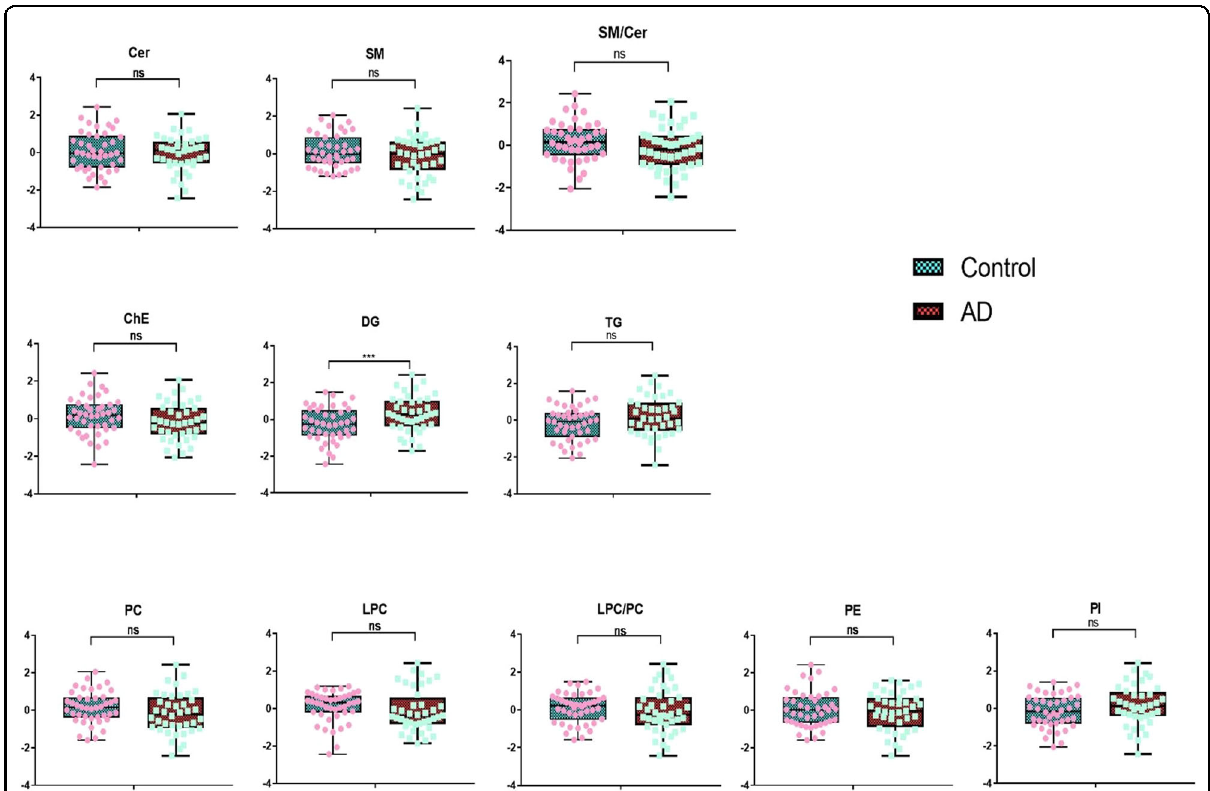
Fig. 3 Residuals of group lipids in AD and control group. Cer ceramides, SM sphingomyelins, ChE cholesteryl esters, DG diglycerides, TG triglycerides, PC phosphatidylcholines, LPC lyso-phosphatidylcholines, PE phosphatidylethanolamines, PI phosphatidylinositols. Dots in the plot represent the residuals of group lipids in each participant. Residuals were obtained after regression out age, sex, BMI, diabetes status, hypertension status, medication status for hypertension, and hyperlipidemia, APOE e4 carrier status, education, and current smoking status. T -tests were used to compare the lipid differences between AD and controls. ns: no signi fi cance, * p <